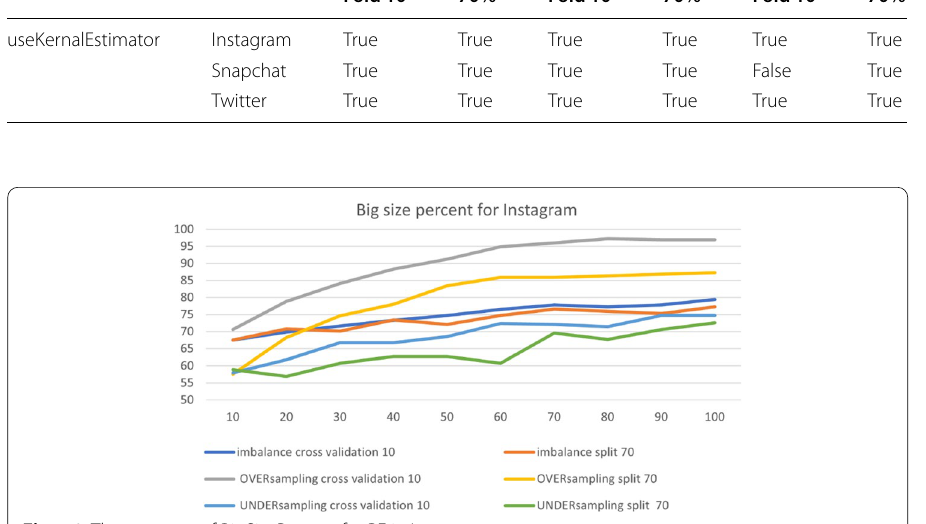
Fig. 16 The accuracy of BigSizePercent for RF in